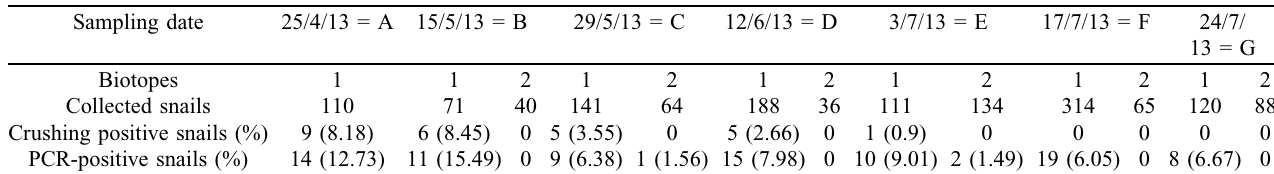
Table 1. Number of snails collected at sites 1 and 2 during the sampling campaign and infection status through microscopy and